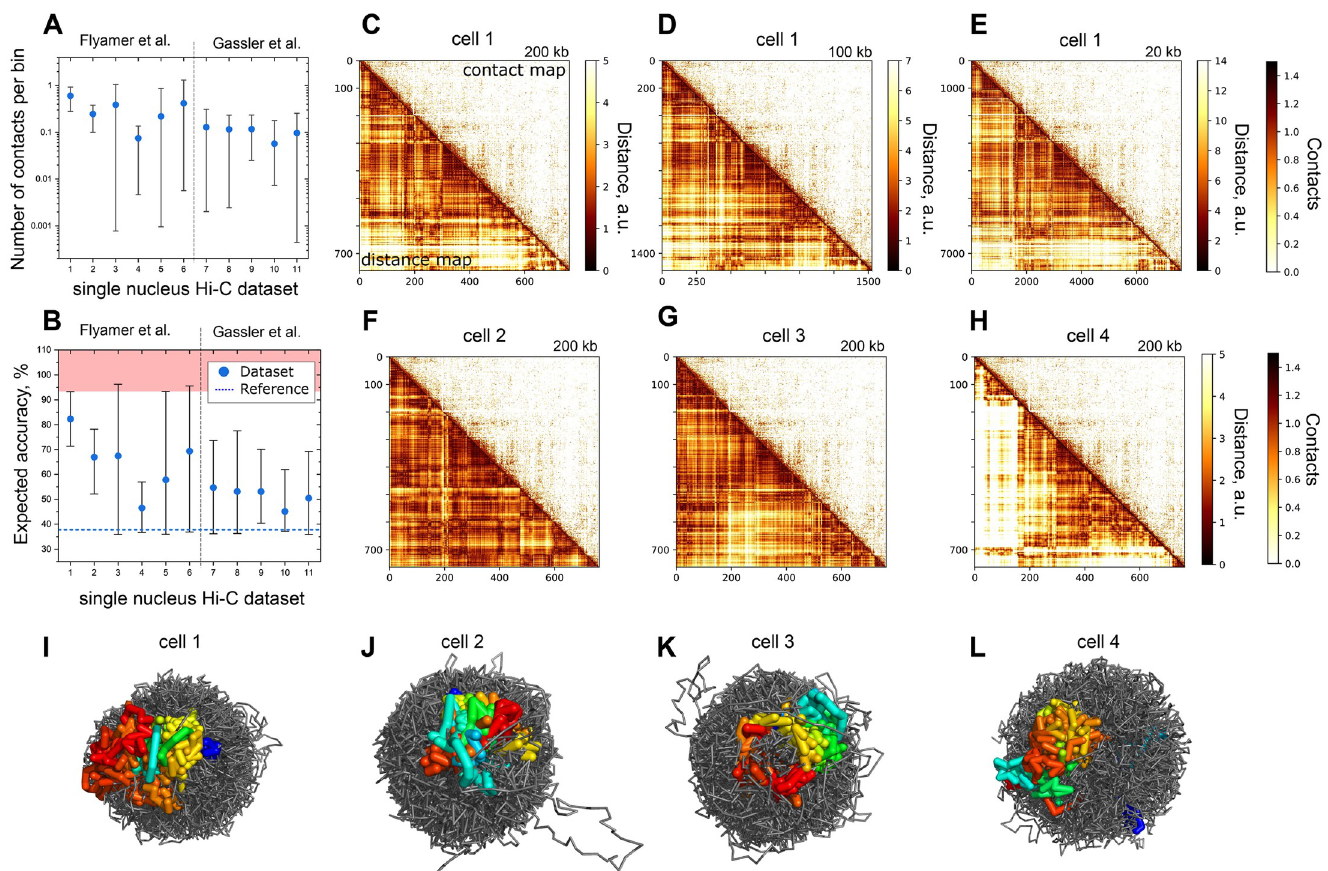
Fig 5. A . Distributions of the number of contacts per bin for single cells from 11 datasets. B . Distributions of the expected accuracy are calculated for the datasets (A) using Eq 1. C-E . The lower left triangle is the distance map of the reconstructed chromosome 4 from cell 1. The upper right triangle is the experimental contact map of the same chromosome. The resolutions are 200 Kb, 100 Kb, and 20 Kb. F-H . Comparison of the distance maps of chromosome 4 from cells 2, 3, 4 with the merged contact map at resolution 200 Kb. I-L . Chromatin conformations of cells 1–4 at resolution 200 Kb. Chromosome 4 is colored rainbow from start to end. The remaining chromatin fiber is